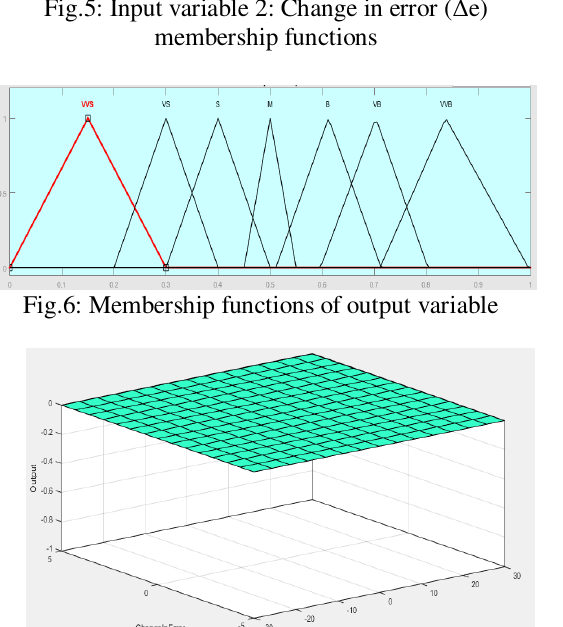
Table 2: PV Specifications